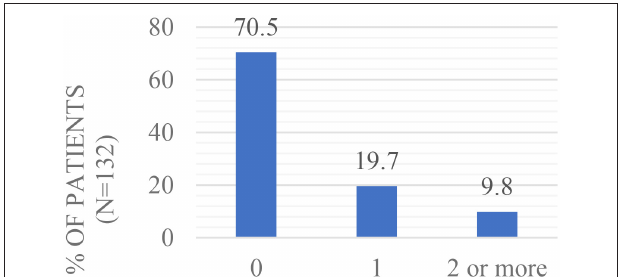
FIGURE 3 | Modified CCI score.